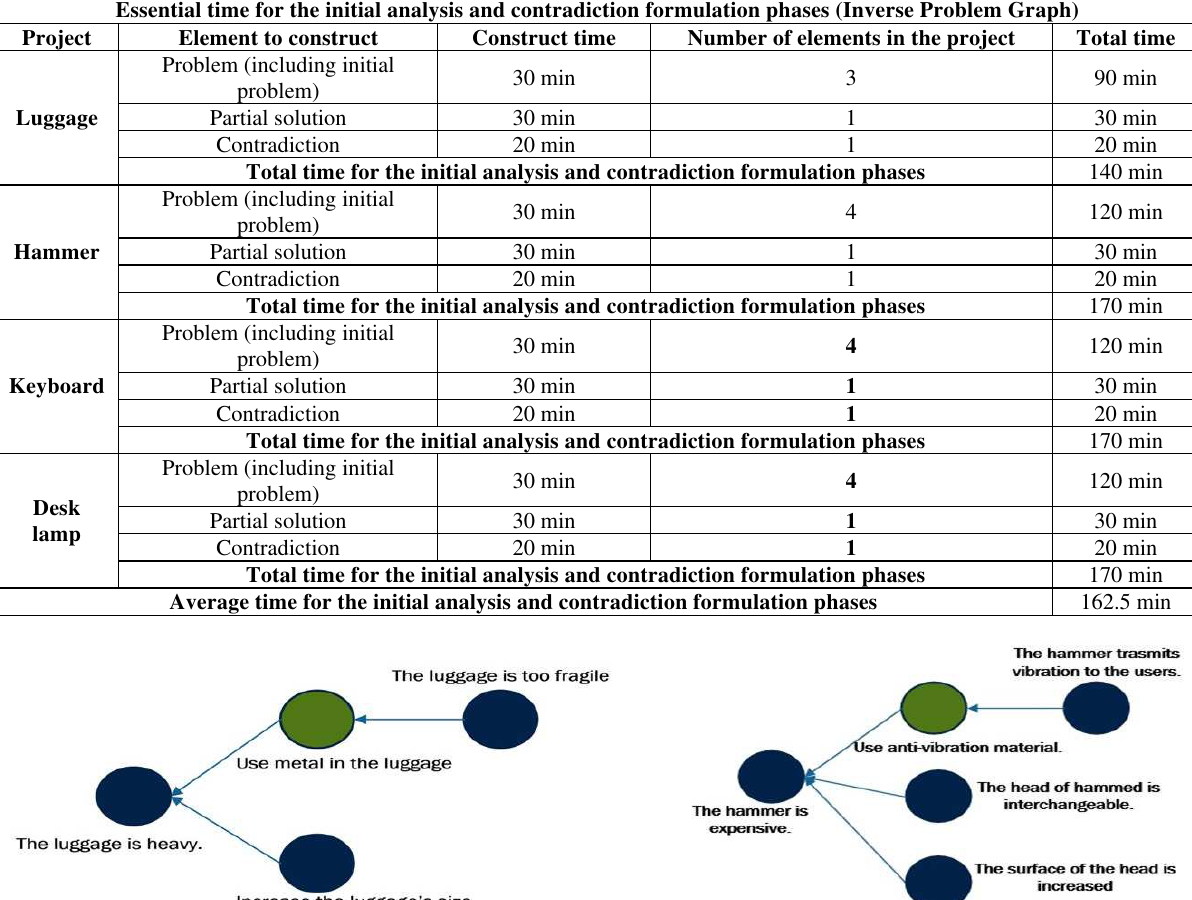
Table 2: Collected information from the application of the IPG method to the four student projects Essential time for the initial analysis and contradiction formulation phases (Inverse Problem Graph)